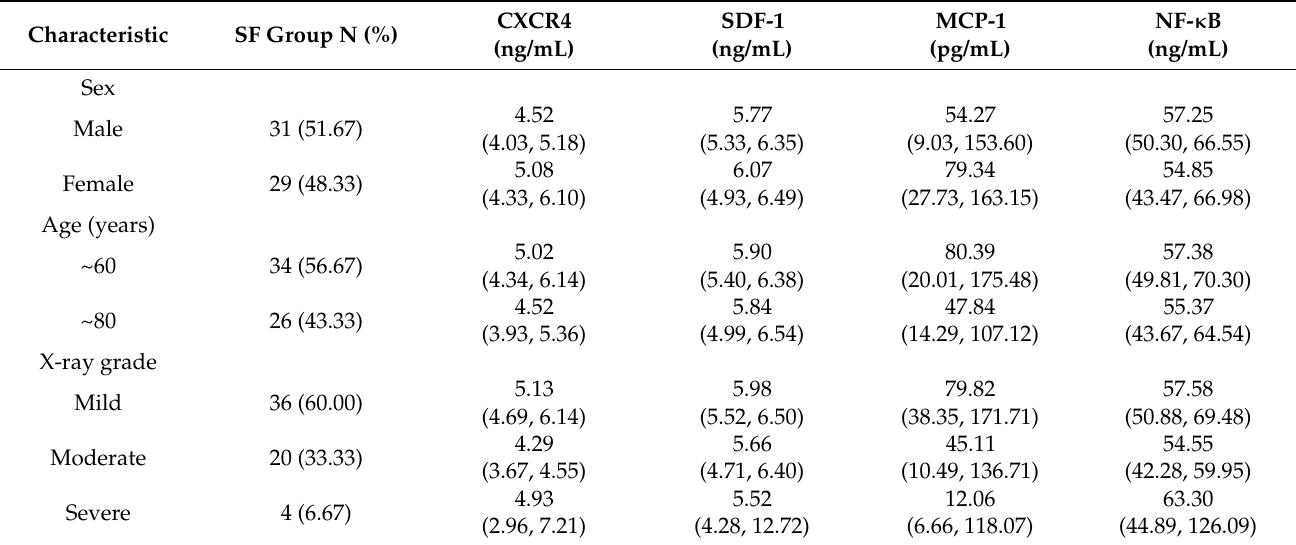
Table 4. Serum SDF-1, CXCR4, MCP-1 and NF- κ B levels in the SF group ( n = 60) by sex, age and X-ray diagnosis grade [M ( P 25 , P 75 )].